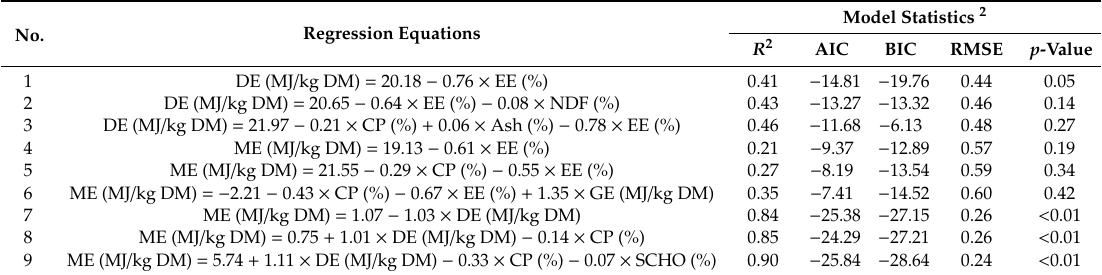
Table 10. Regression equations for digestible energy (DE) and metabolizable energy (ME) in corn from and chemical characteristics 1